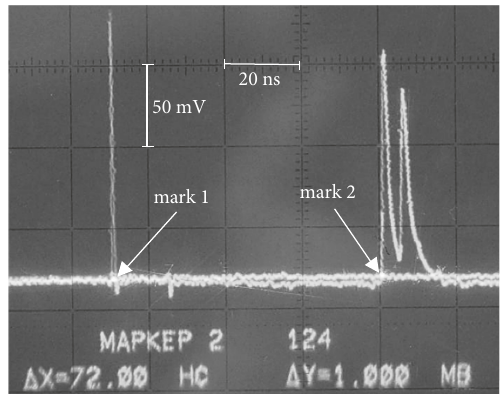
Figure 12: Oscillograph pattern of a source signal (with 20 dB attenuator) and a signal at the far end of the probing line ( 𝑉4 ) for the structure (without attenuator) from Figure 2(a) when 𝑅2 = 𝑅4 = 100 Ω